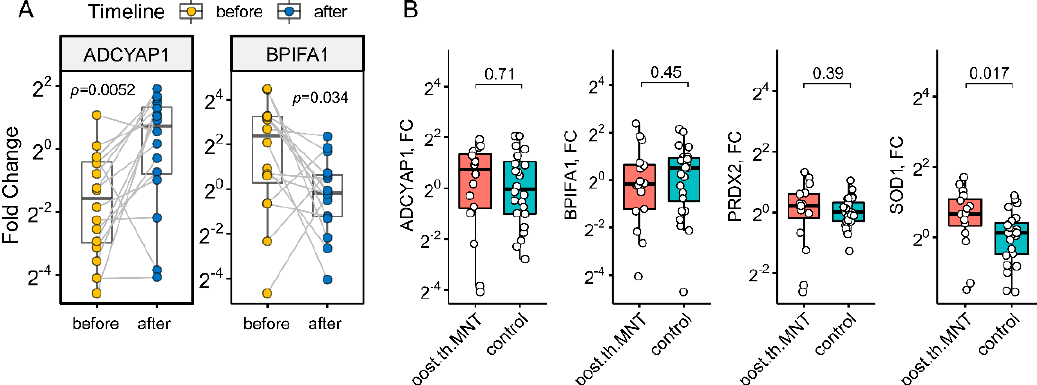
Figure 5. Boxplots showing gene expression (fold change (FC), log2-scale) in annotated groups ( A ) before and after treatment ( n = 16, two-tailed paired Wilcoxon test, middle nasal turbinate) ( B ) in treated (middle nasal turbinate mucosa) and control samples (two-tailed Mann–Whitney test). Horizontal lines represent median with interquartile range. p < 0.05 was considered significant.